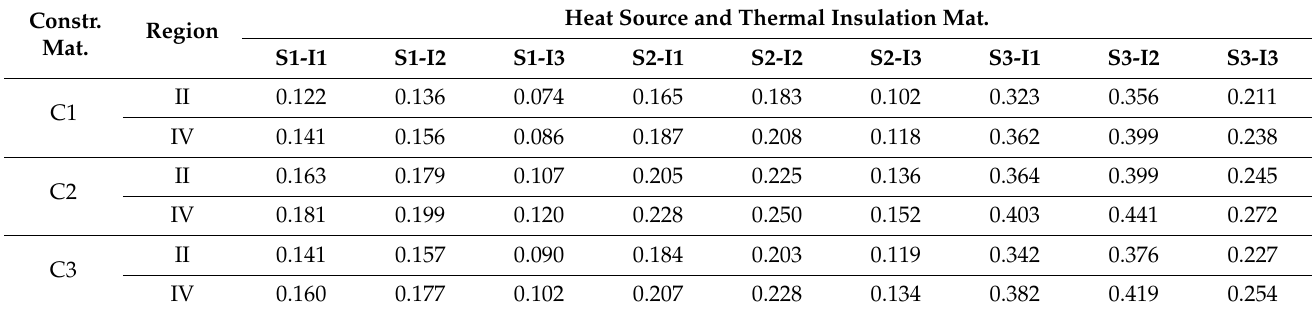
Table 6. Thermal insulation optimum thicknesses for economic reasons d opt (m). Constr. Mat.